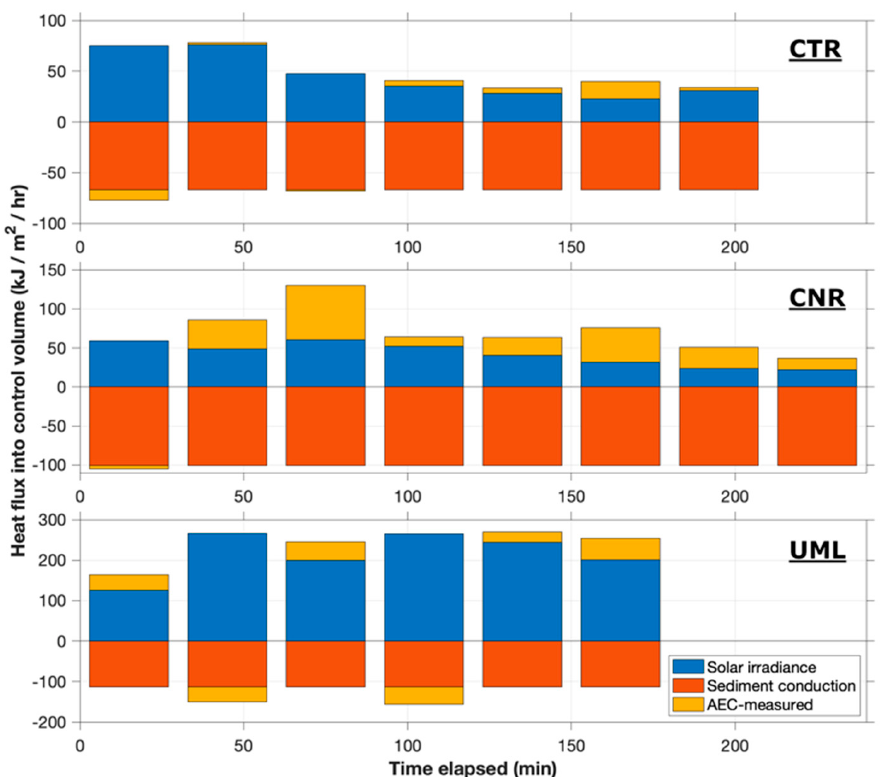
Figure 7. Benthic heat flux balance at all sites. Positive heat fluxes represent input to the control volume (downward solar irradiance or downward eddy flux at the sensing volume), while negative fluxes represent heat leaving the volume (downward conduction at the sediment-water interface or upward eddy flux at the sensing volume).